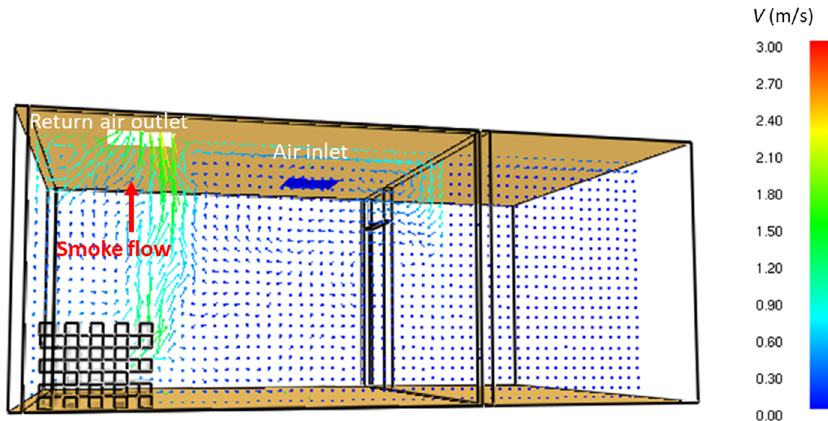
Figure 11. Airflow vector slice at 30 s for the “FCU on” mode in the square room.